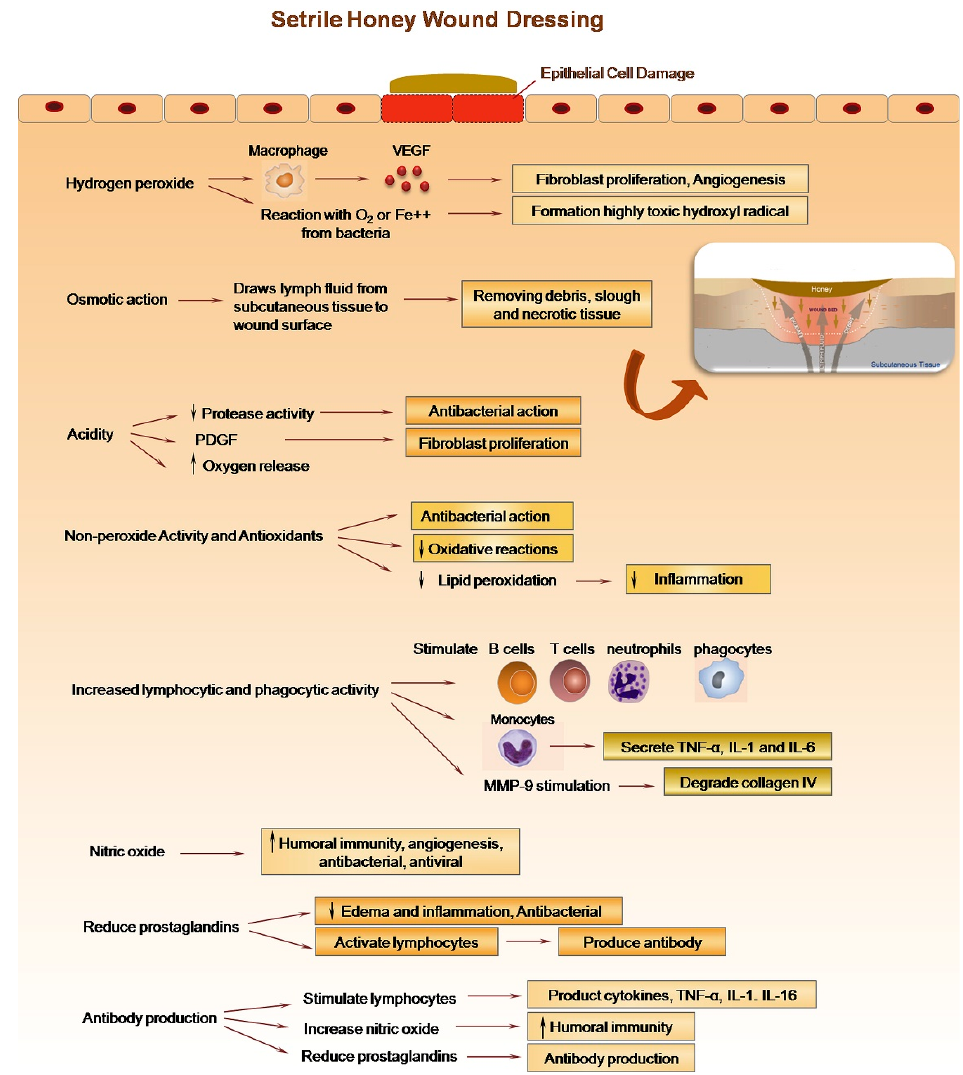
Figure 2. Mechanism of honey activity during wound healing. The effects of honey on the immune system, its debridement action, and its role in wound regeneration were boosted and stimulated by its antimicrobial, anti-inflammatory, and antioxidant activities, which significantly contributed to the wound healing process. Reproduced from [30] with permission from Elsevier.